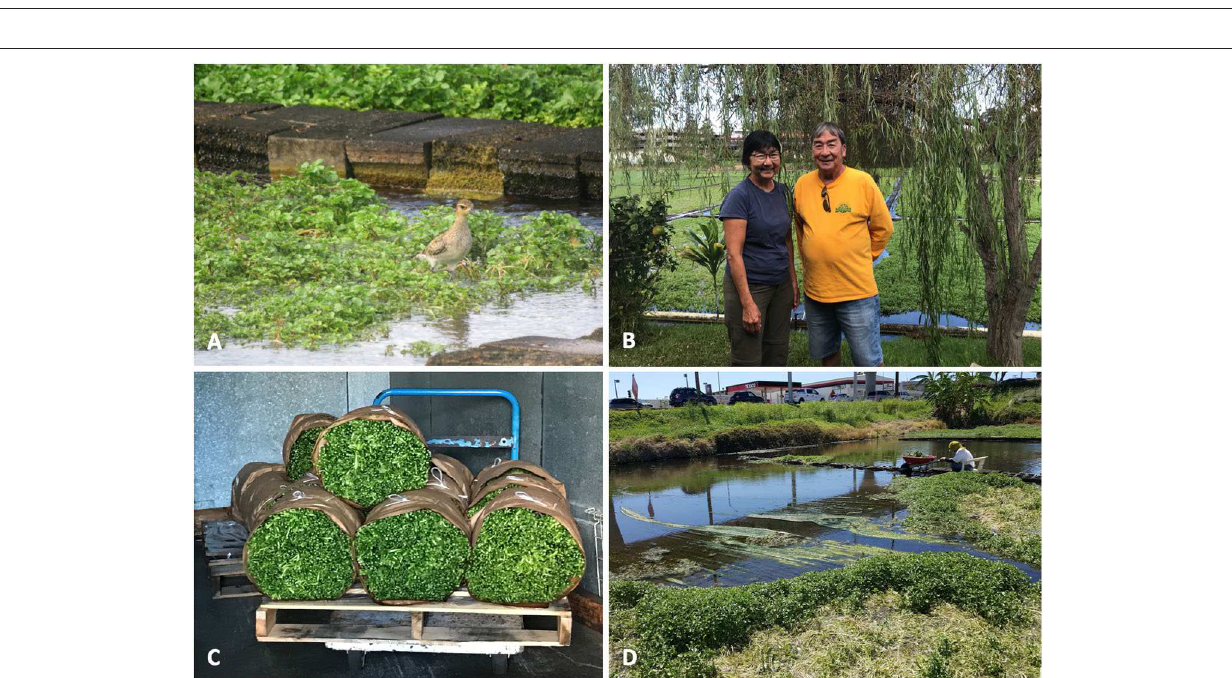
FIGURE 4 | Multiple benefits associated with 100% spring-fed Sumida Farm. (A) Important habitat for birds, fish, and insects. (B) Cultural and community importance: Barbara and David Sumida, third-generation Sumida siblings and farmers. Moriichi and Makiyo Sumida, Barbara and David’s grandparents started the farm in 1928. (C) Provision of goods: Bushels of fresh watercress bundled for delivery. (D) Employment: Sumida farmworker tending to the